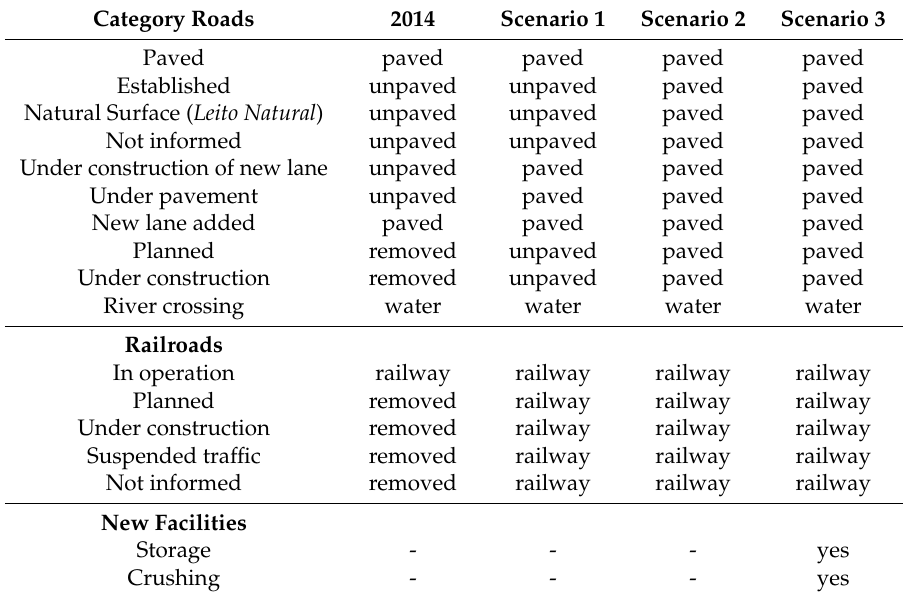
Table 2. Changes in infrastructure status across simulation